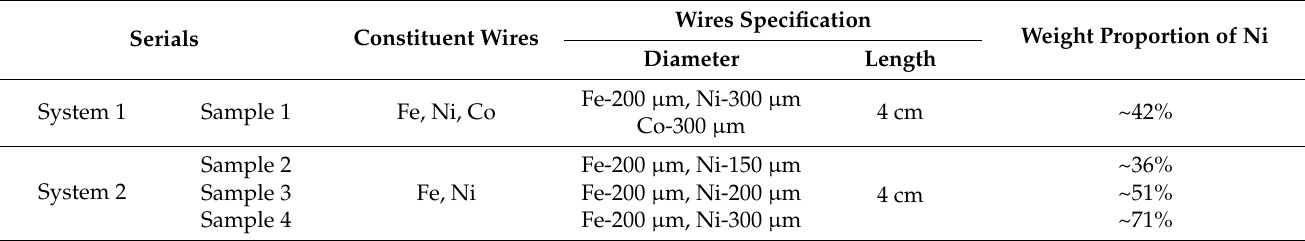
Table 1. Detailed load parameters used in